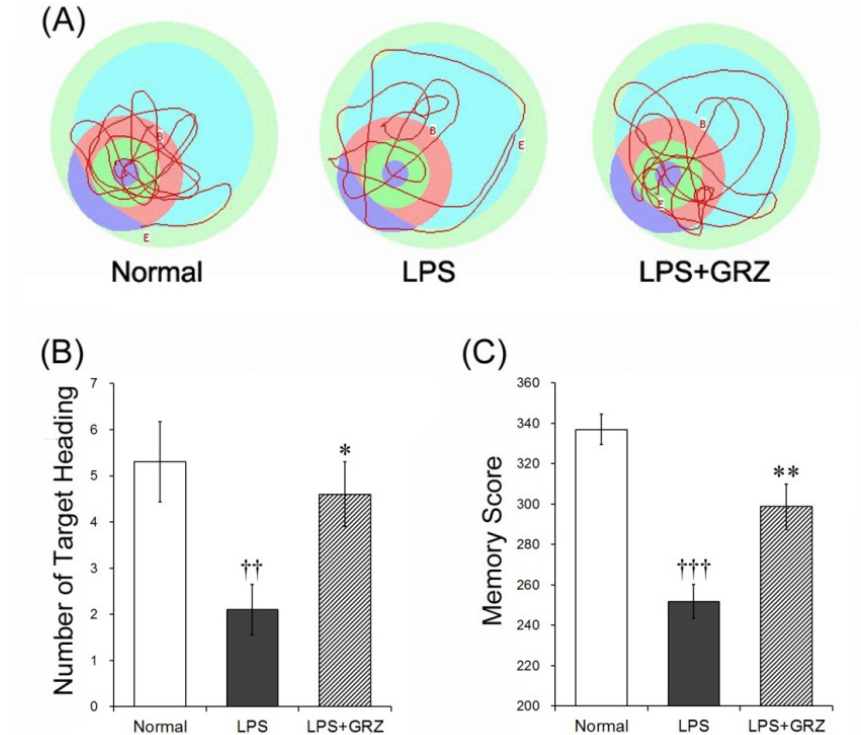
Figure 7. Effects of GRZ on the retention memory test. Representative swimming tracts of the normal, LPS, and LPS+GRZ groups ( A ) GRZ significantly increased the number of target heading on platform site ( B ) and memory score; and ( C ) in the retention test. Data are represented by mean ± SEM (n = 12 in each group; †† p < 0.01; ††† p < 0.001 compared to the normal group; * p < 0.05; ** p < 0.01 compared to the LPS